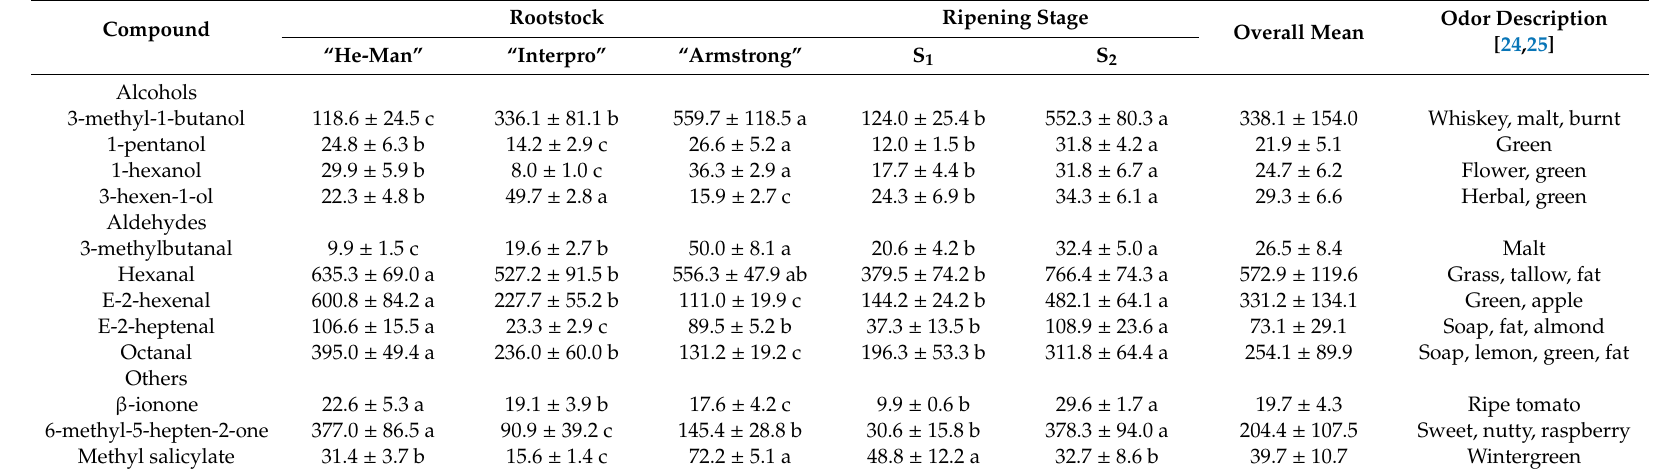
Table 5. Peak area ( × 10 6 ) of volatile organic compounds detected in tomatoes “Sir Elyan”, as a ff ected by rootstock and ripening stage (main e ff ects) (mean ± standard error). Di ff erent letters among factor’s means indicate significance at Fisher’s LSD test ( p =